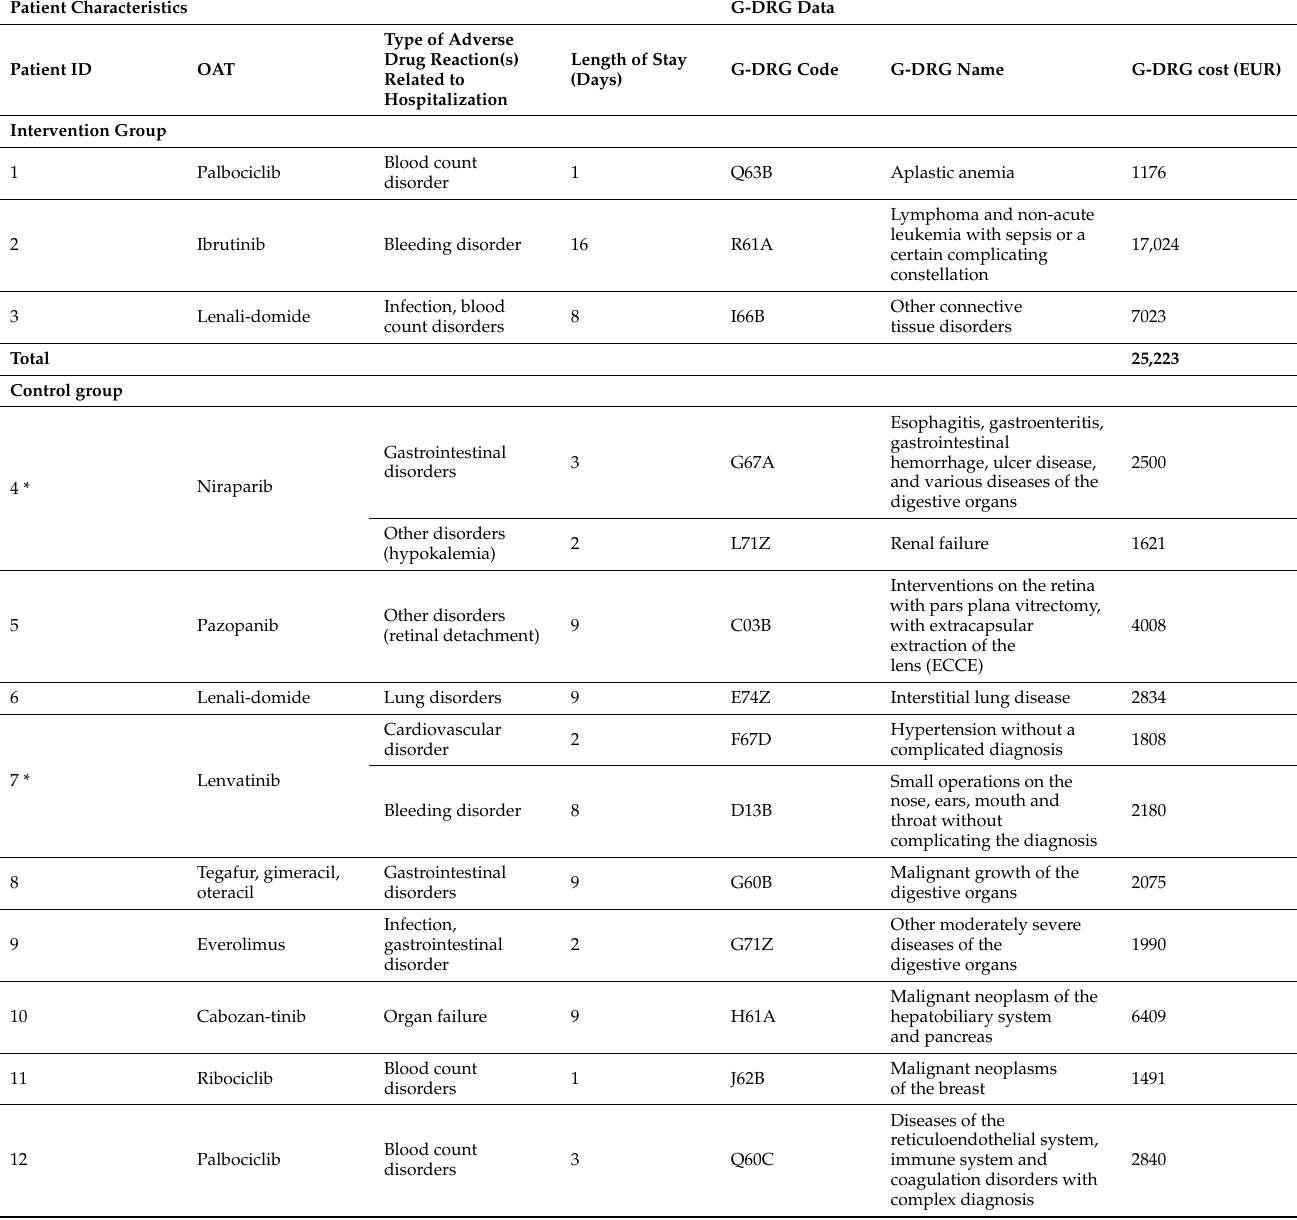
Table 4. Types of adverse drug reactions, length of hospital stays, respective DRG data, and cost in the patients with OAT-related hospitalizations within